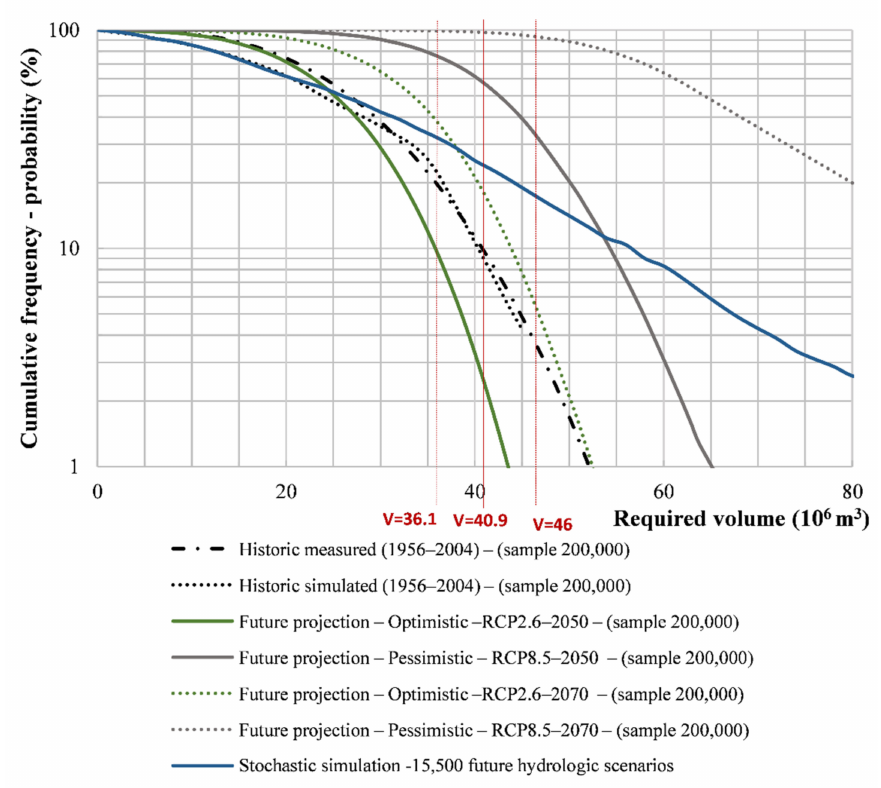
Figure 6. Cumulative frequency—the probability (%) of the reservoir required volume (in 10 6 m 3 ) assuming a zero-height dam and based on the novel methodology of Yannopoulos and Demetra- copoulos (2018): (a) the randomly generated 200,000 years based on the historic measured and the simulated runoff data (1956–2004), (b) the future IPCC climatic scenarios in the near and the far future and (c) the 15,500 probabilistic scenarios of 10 years duration (using